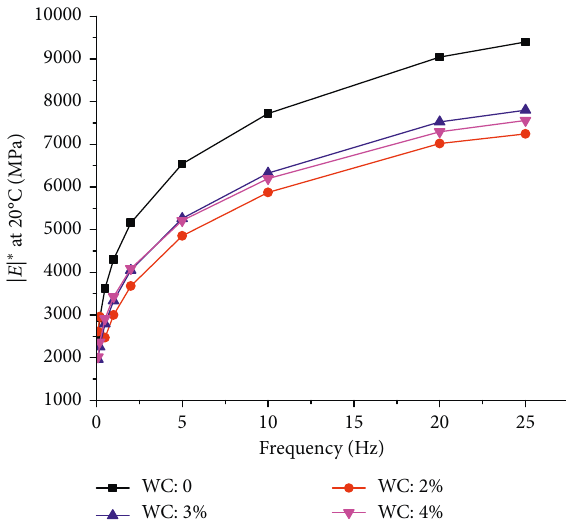
Figure 12: SBS#AC-13-type normal-temperature dynamic